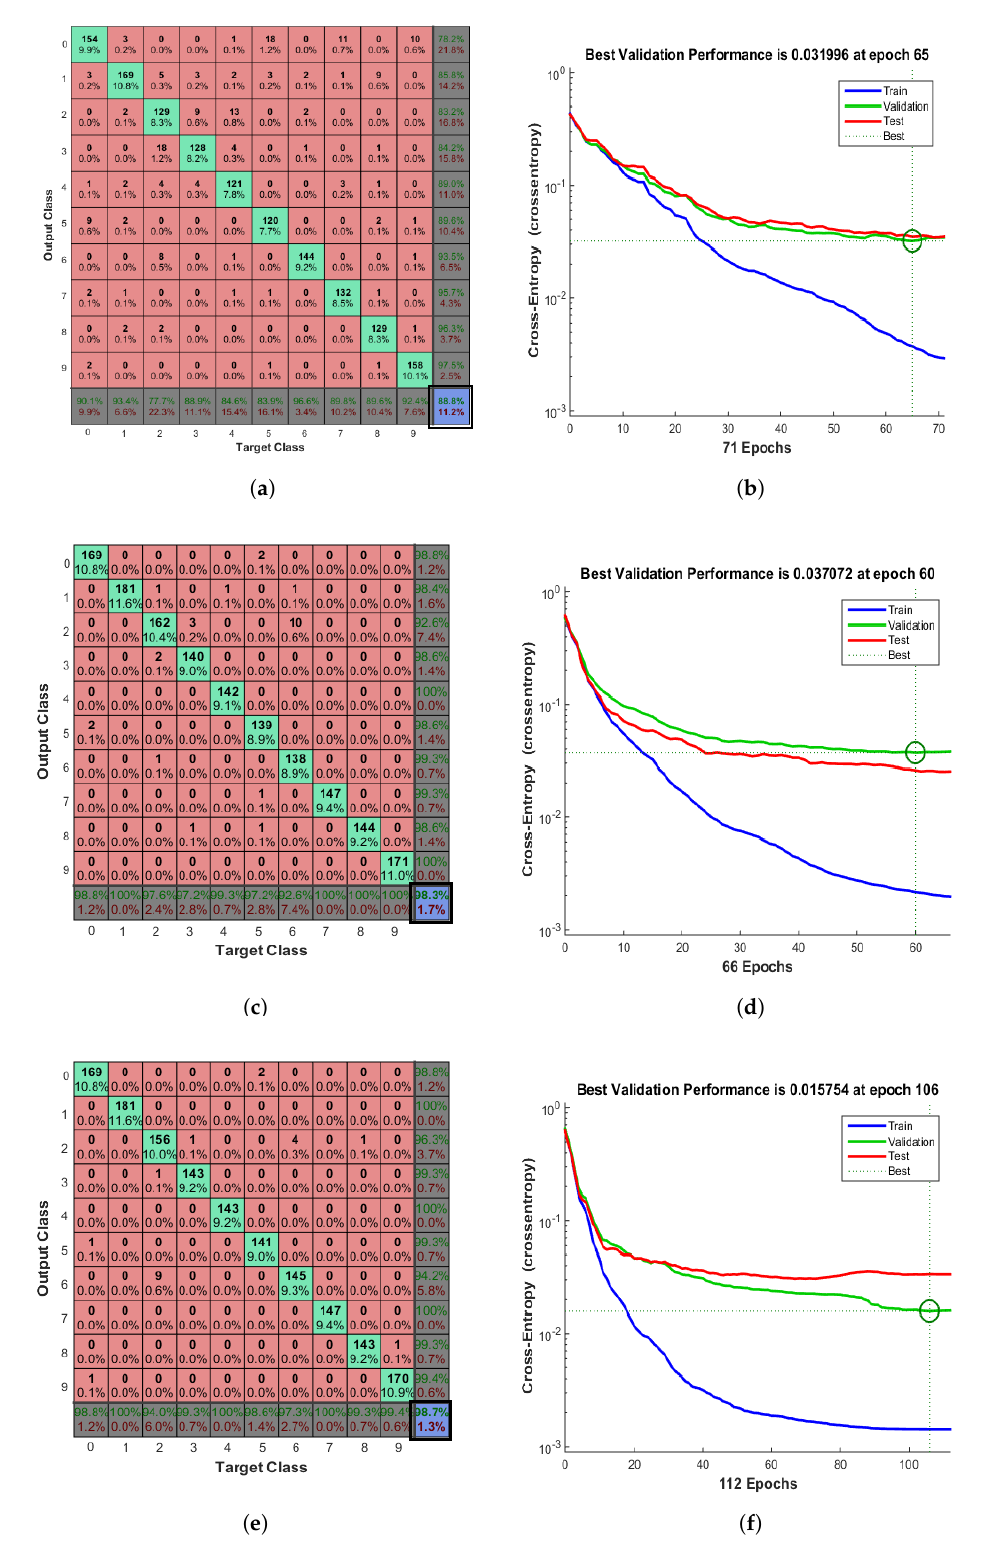
Figure 15. Confusion matrices and respective performance graphs in Urdu handwritten numeral classification. ( a ) Accuracy result with 10 hidden neurons; ( b ) best validation performance with 10 hidden neurons; ( c ) accuracy result with 30 hidden neurons; ( d ) best validation performance with 30 hidden neurons; ( e ) accuracy result with 50 hidden neurons; ( f ) best validation performance with 50 hidden